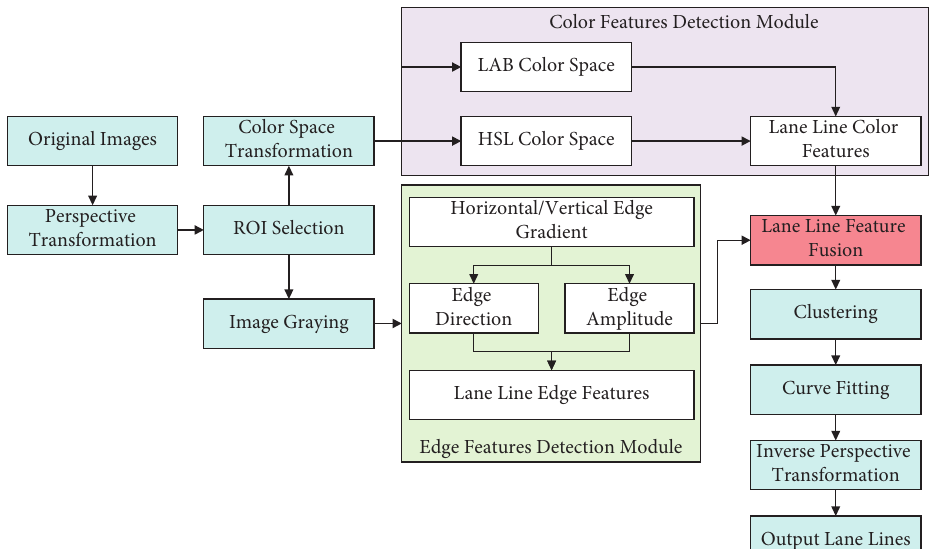
Figure 1: Framework of traditional vision-based lane detection